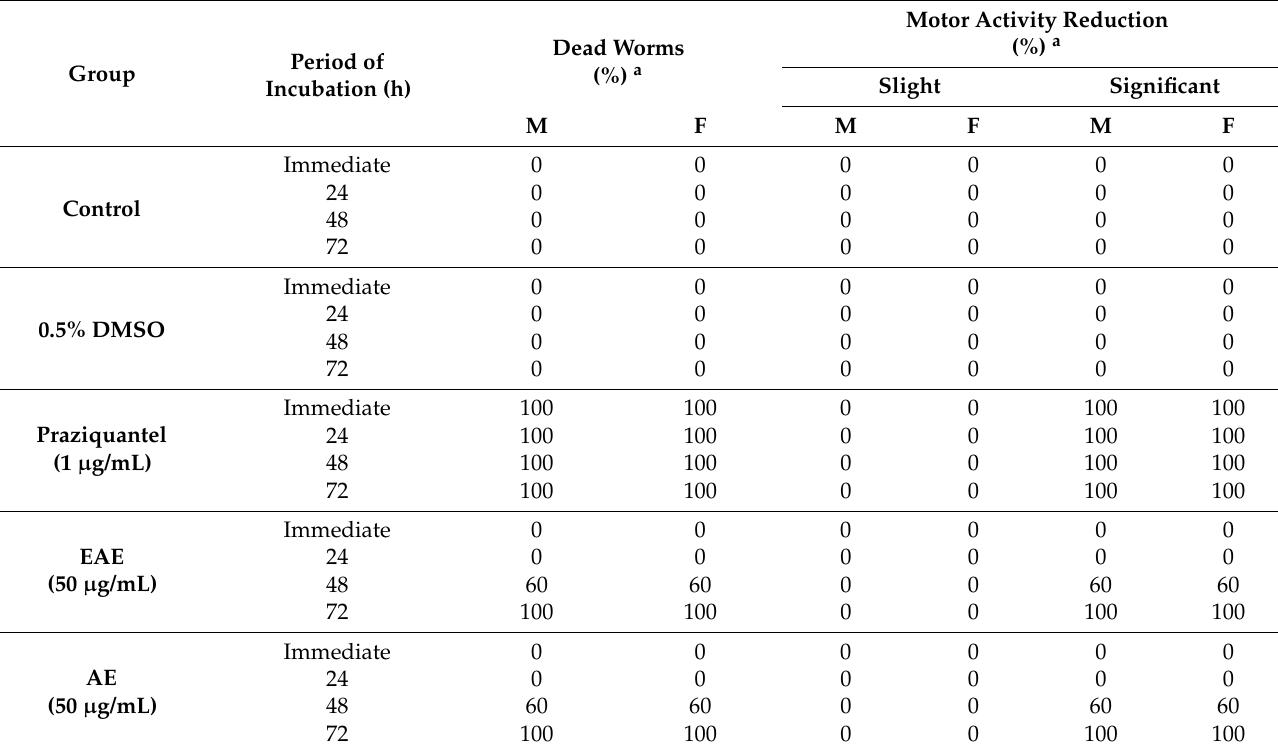
Table 3. Effect of the extracts obtained from the M. linifera against adult worms of Schistosoma mansoni .